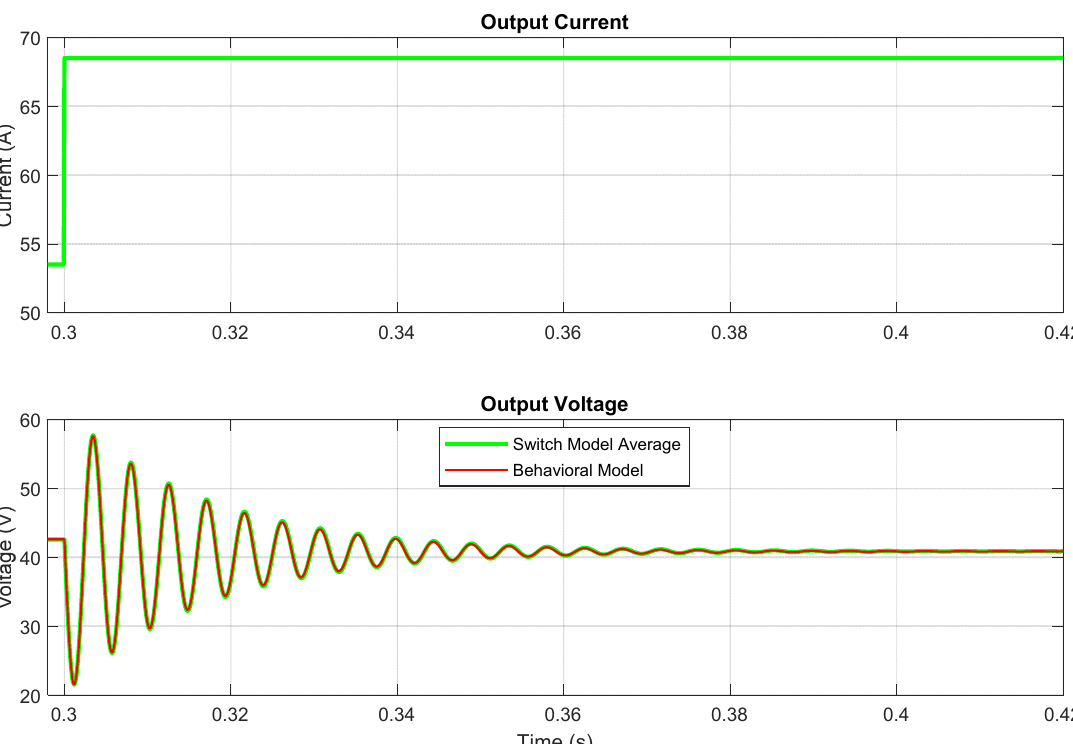
Figure 10. Bus current and bus voltage waveforms comparison for step change in output current.